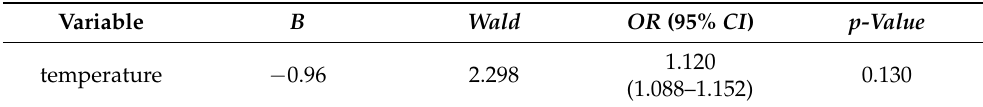
Table 5. Logistic regression analysis of the effect of photoperiod on S. caerulea ’s female